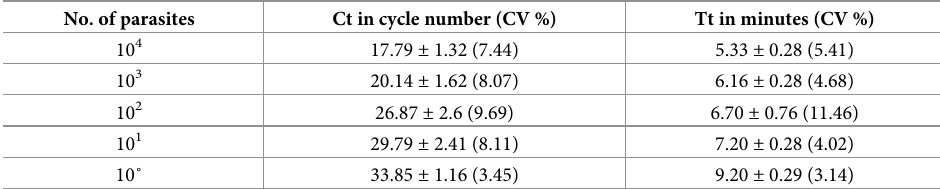
A standard curve using L . donovani parasites ranging from 10 4 − 10 0 was performed by qPCR and RPA as described in materials and methods. All data are expressed in mean ± SEM and CV in percentage; Ct: cycle threshold in qPCR, Tt: time threshold in RPA, CV %: inter assay coefficient of variation, NA: not